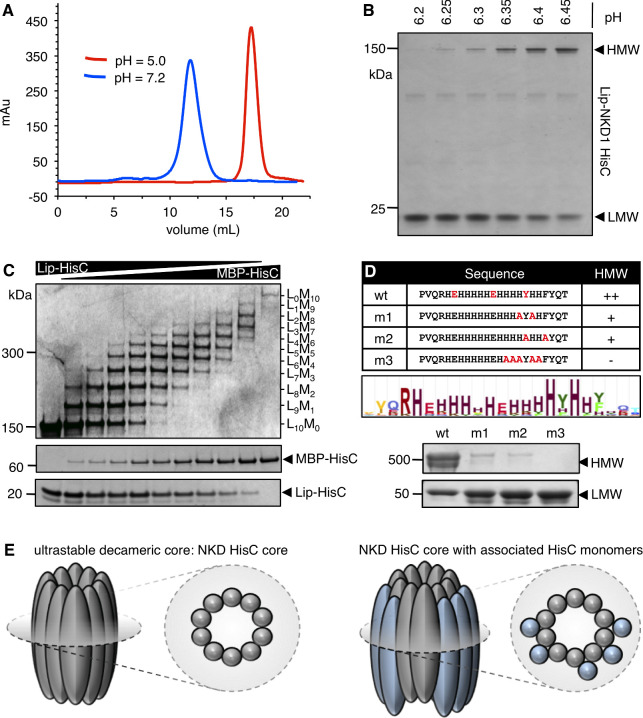
NKD1 HisC forms ultra-stable decameric core aggregates.(A, B) pH-dependent aggregation of purified recombinant Lip-NKD-HisC in vitro, monitored by (A) SEC or (B) PAGE. (C) Co-aggregation assays after mixing Lip-NKD-HisC and MBP-NKD-HisC at different ratios, revealing a decameric core (note that the self-aggregation of MBP-NKD-HisC is considerably less efficient than that of Lip-NKD-HisC, presumably owing to the large size of the MBP tag). (D) Mutational analysis, revealing that in vitro aggregation depends on conserved aromatic and charged residues within HisC. (E) Cartoon of NKD-HisC core and associated HisC monomers.